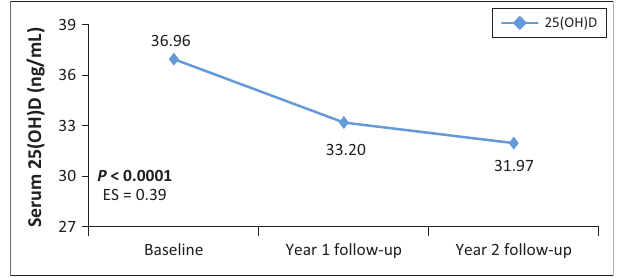
FIGURE 3: Serum 25-hydroxyvitamin D changes over 2 years from baseline.